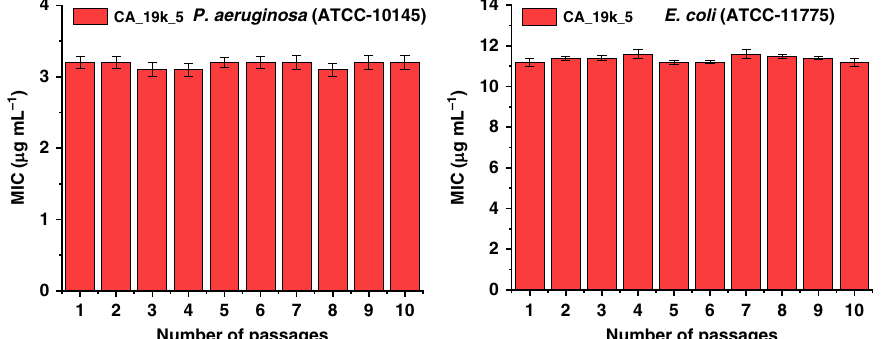
Fig. 6 Drug resistance study of CA_19k_5 against P. aeruginosa and E. coli upon multiple sublethal dose treatment. The Data are collected from the three replicates and the error bars represent the s.d. of three